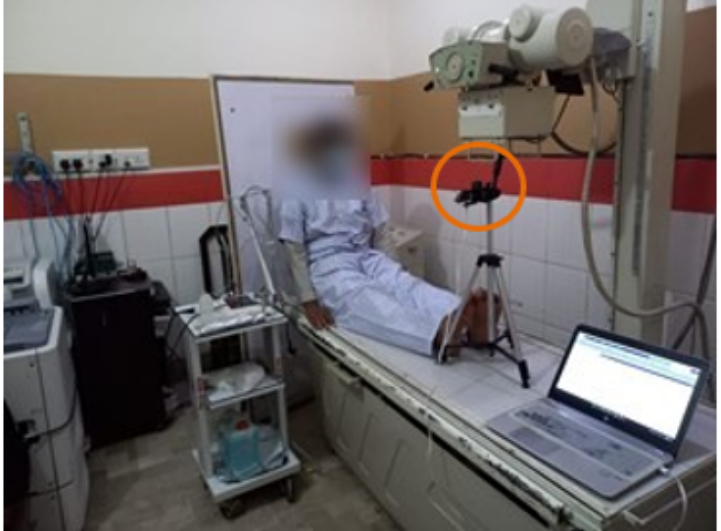
Figure 4. Data collection with the subject sitting in front of the